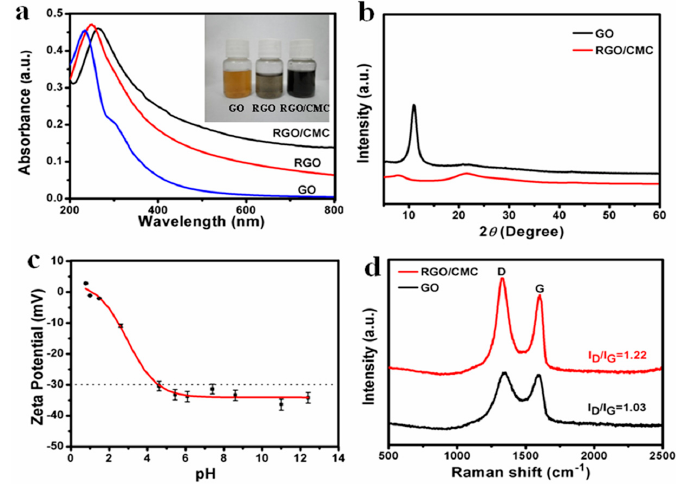
Figure 2. ( a ) UV absorption spectra of RGO/CMC, RGO and GO; ( b ) XRD diffraction patterns of GO and RGO/CMC; ( c ) Zeta potential of RGO/CMC aqueous solution; ( d ) Raman spectra of GO and RGO/CMC.